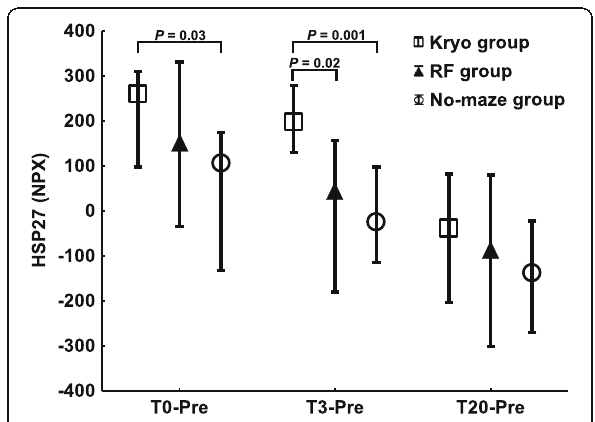
Fig. 4 Heat shock protein 27 (HSP27) changes from preoperatively (Preop) to the end of surgery (T0), and 3 h (T3) and 20 h (T20) postoperatively displayed as median and 25th to 75th percentile in the three study groups. P values indicate the significance level at post hoc comparisons of mean ranks of pairs of groups when multiple comparisons of mean ranks for all groups, Kruskal-Wallis test showed significance. NPX: Normalized Protein